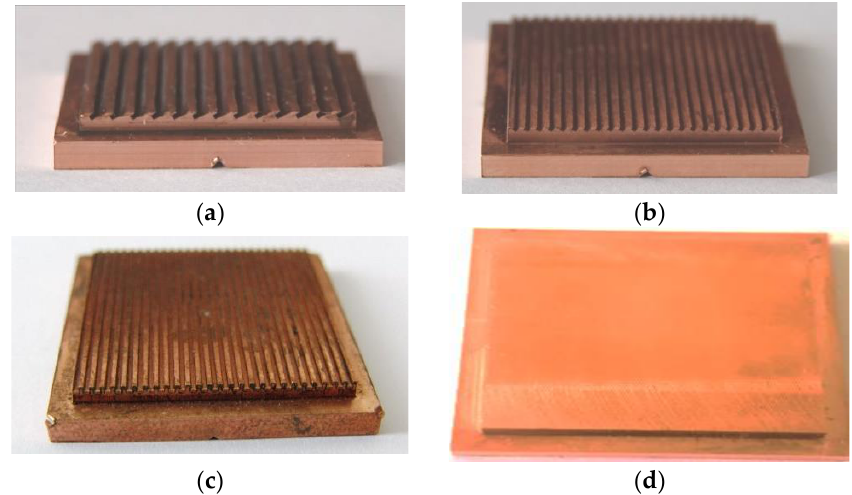
Figure 2. Surface photographs: ( a ) MC-0.5-0.3-1.0-60; ( b ) MC-0.5-0.3-1.0-30; ( c ) MC-0.5-0.3-1.0; ( d ) smooth surface. Table 1. Surface codes and